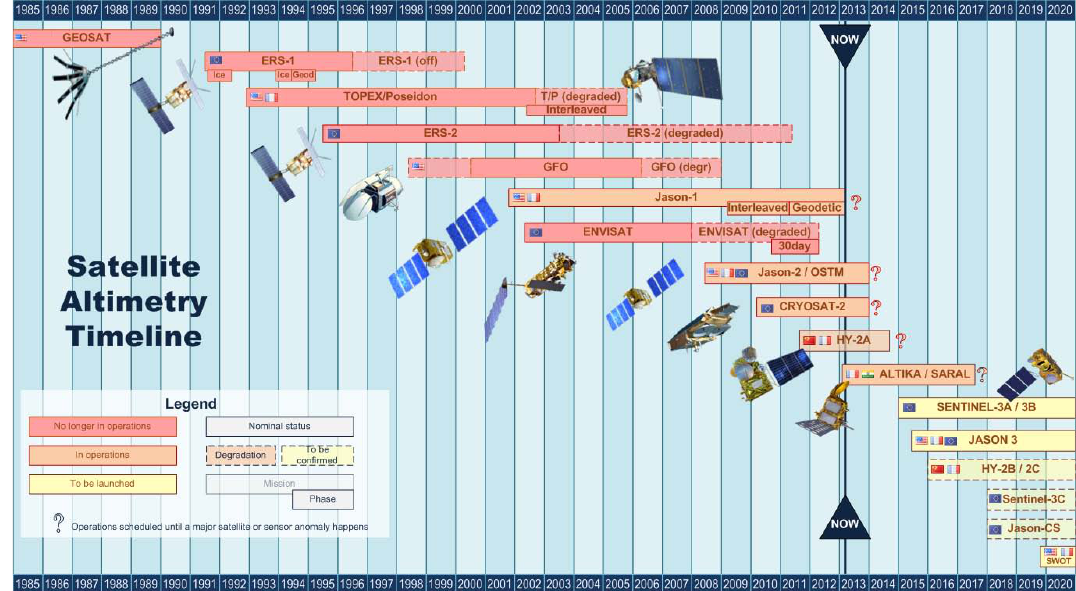
Fig. 1. Past, present and future altimeter missions (Courtesy G.